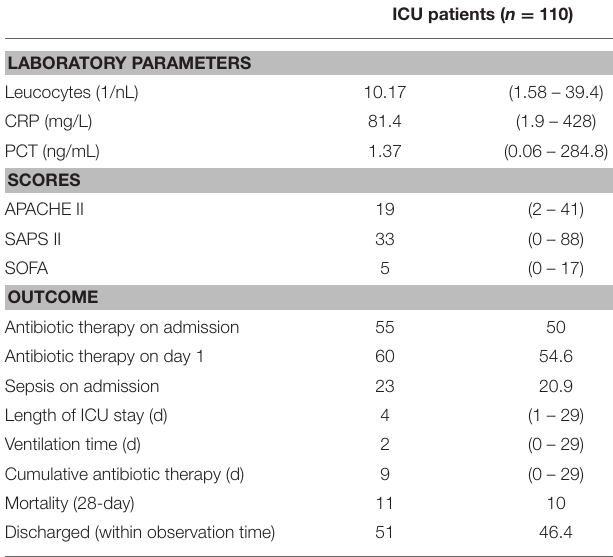
TABLE 2 | Laboratory parameters, scores and outcome of study TABLE 1 | Baseline demographic and medical information of study population. ICU patients ( n = 110)